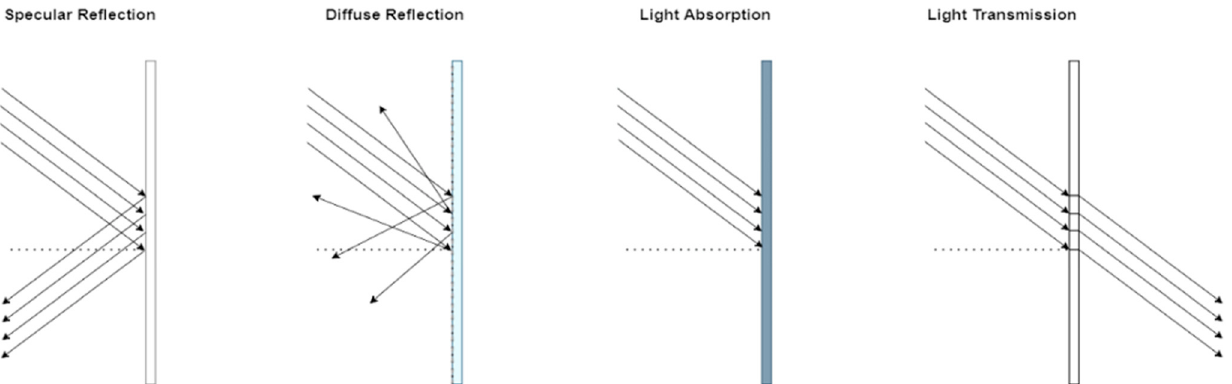
Figure 2. Behavior of Light on various surfaces for specular and diffuse reflection, light absorption and light transmission.